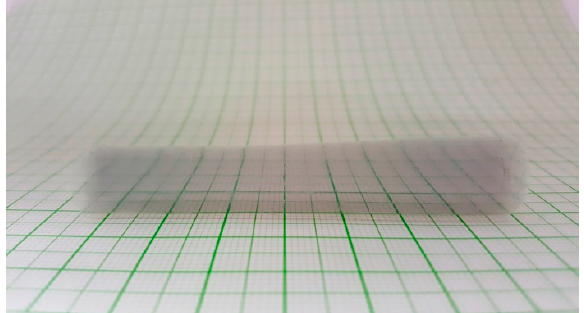
Figure 1. A photograph of a transparent base-catalyzed monolithic silica aerogel against a metric grid. The appearance of the grey color is the consequence of extensive aggregation of gold nanoparticles.